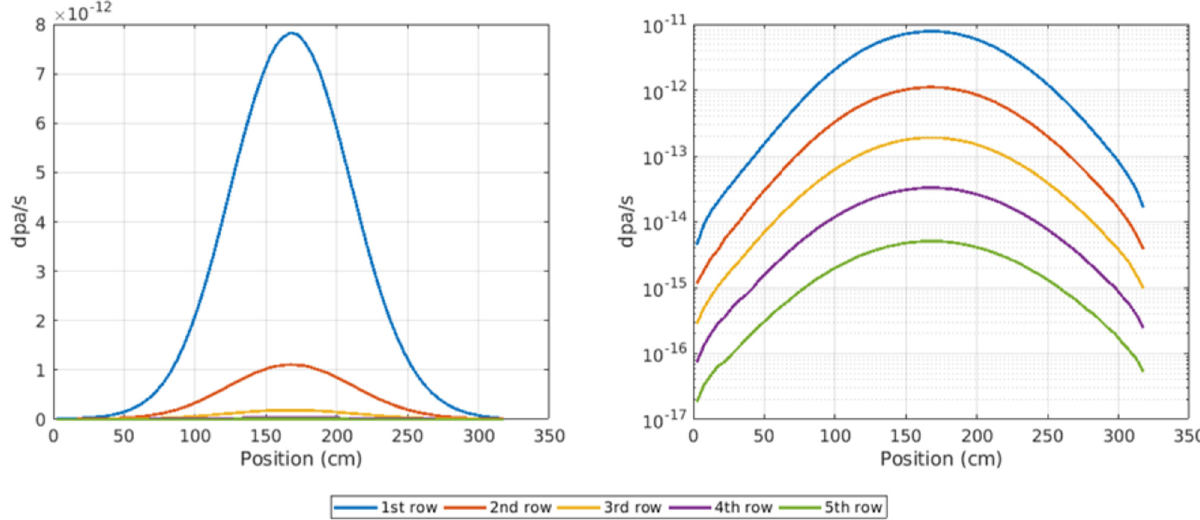
Fig. 21. Axial traverses of damage per atom in the hexagonal tube of neutron shielding, linear scale (left), logarithmic scale (right).